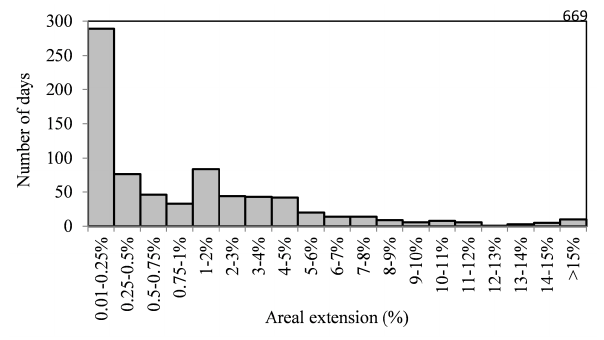
Fig. 5. Distribution (in percent) of the multiplicity (M) of CGD Figure 5. Distribution (in percent) of the multiplicity (M) of AEDCGD recorded over 666 recorded over Portugal in 2003–2009. Portugal in 2003-2009. 667 LIGHTNING IN PORTUGAL: PATTERNS AND FORCING